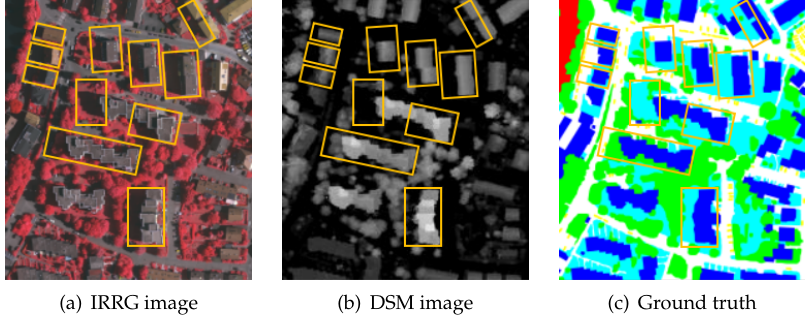
Figure 1. The sample of the IRRG, DSM images, and corresponding ground